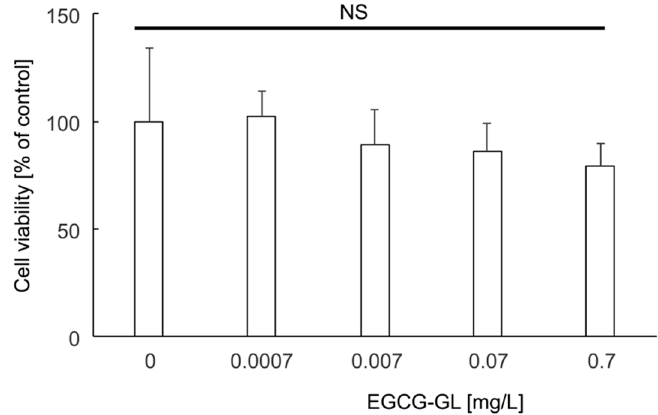
Figure 2. EGCG-GL exhibited no cytotoxicity against RAW 264.7 cells at the concentrations we tested. Percent of cell viability to the control is shown (n = 3). NS: No significant difference among the groups.